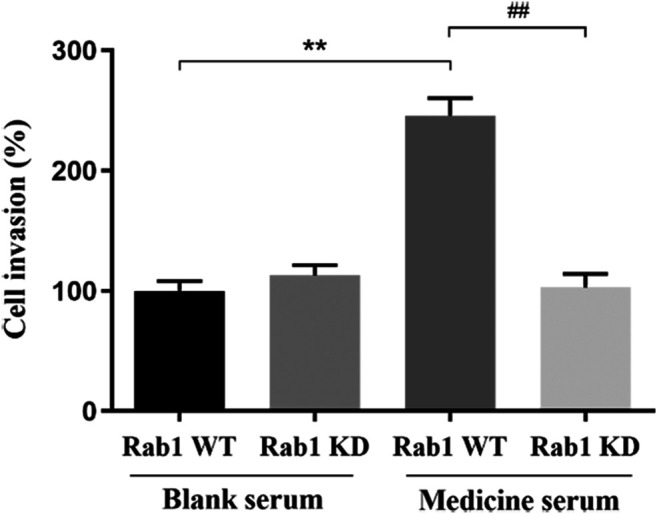
The effect of FYXN serum on the migration of BMECs, **p < 0.01, compared with NC + Rab1WT group; ##p < 0.01, compared with FYXN + Rab1WT group.